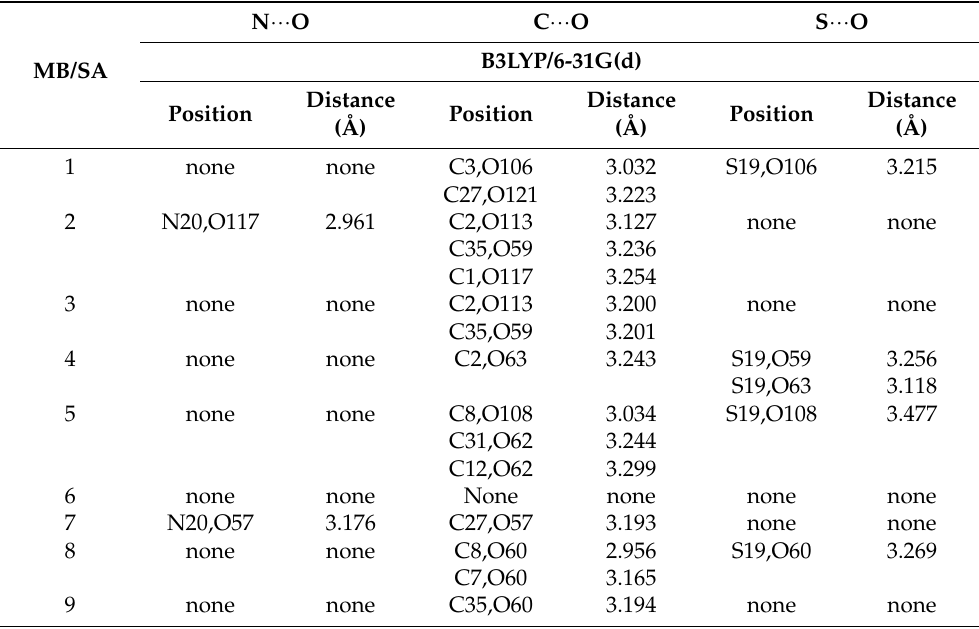
Table 4. Intermolecular interactions observed for MB/sodium alginate (MB/SA)